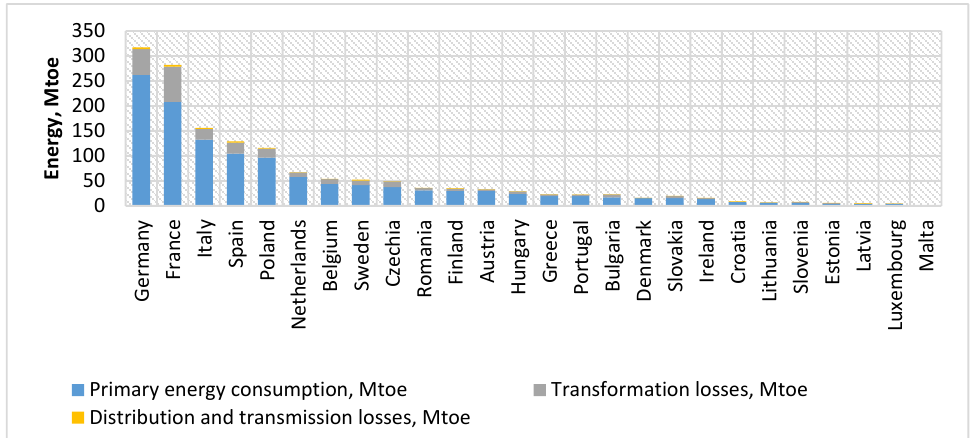
Figure 3. Primary energy consumption and energy losses, 2020 (based on the Eurostat’s data (ec.europa.eu/eurostat/, accessed on 17 August 2022); © European Union, 1995–2022).